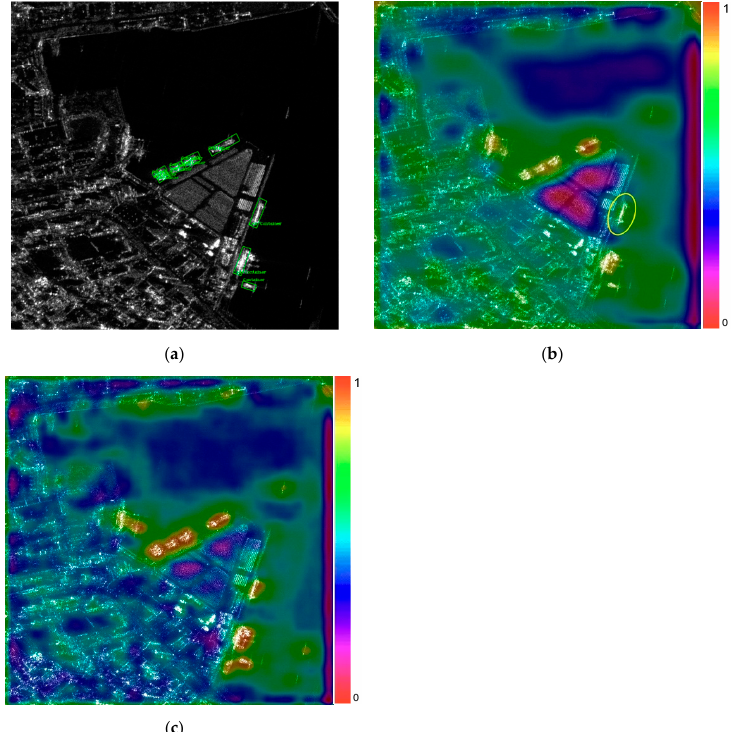
Figure 9. Visualization of the confidence heatmaps. The yellow ellipse represents missing ship. ( a ) Ground truth in SAR image. ( b ) Visualization of confidence heatmap extracted by convolution in baseline without SPG RPN. ( c ) Visualization of confidence heatmap extracted by deformable convolution in SPG RPN (blue feature map in Figure 2).